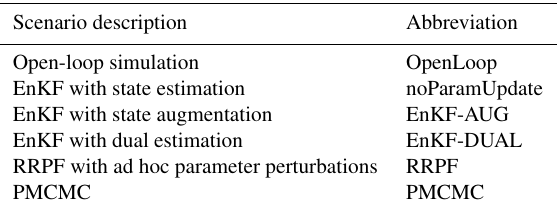
Table 3. Summary of the different numerical experiments used in this paper for CLM and VIC-3L and their respective abbreviations used in the subsequent tables and